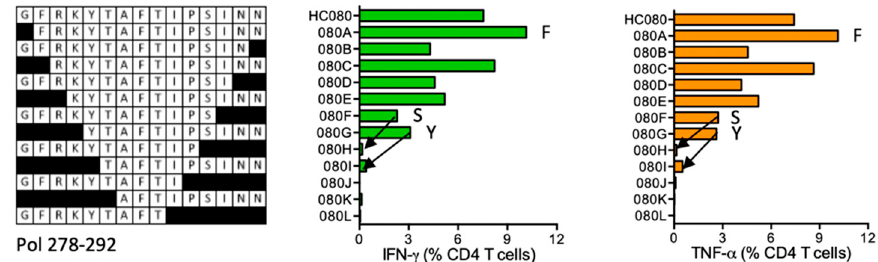
Figure 6. HC080 / VID 411—definition of CD4 + T-cell epitopes in HIV-1 protein Pol. Expanded PBMCs from volunteer 411 were stimulated with truncated peptides (left) in ICS and the elicited production of IFN- γ (green) and TNF- α (orange) by CD4 + T cells was determined. Arrows in the graph and amino acids F, S and Y indicate the stimulatory peptide termini.